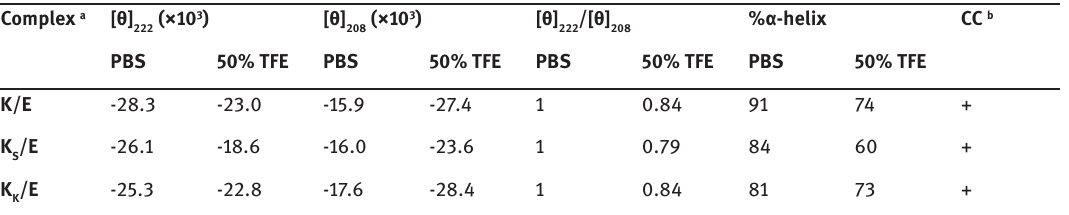
a Complex refers to mixtures of the stated compounds with equimolar concentrations. b CC means coiled coil, and + signifies a significant decrease in the [ɵ] /[ɵ] ratio from benign to 50% TFE in PBS, indicative of the folded coiled-coil structure in PBS . 222 208